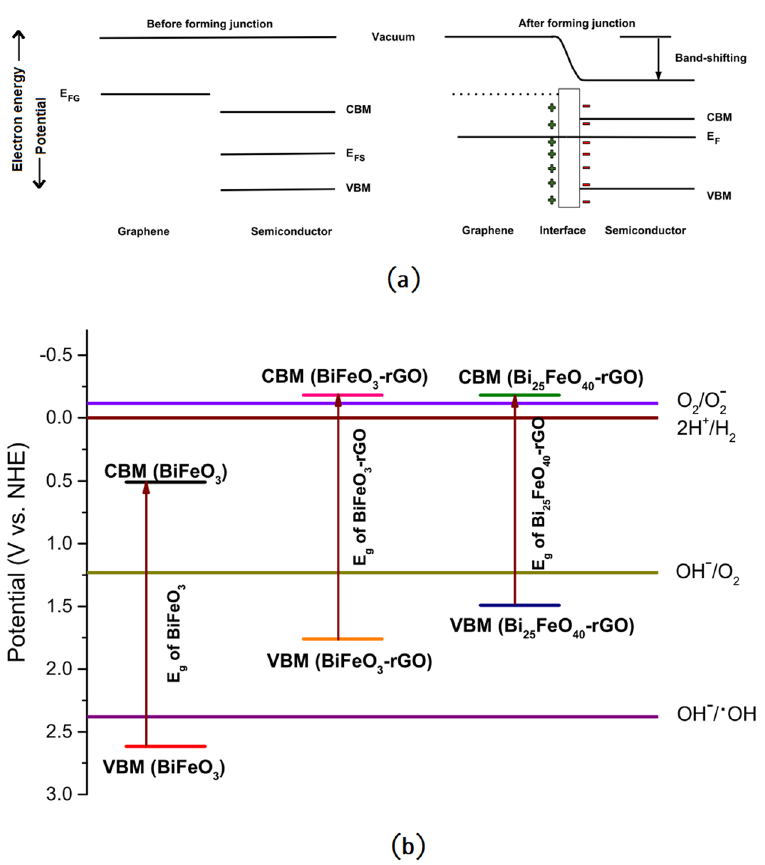
Figure 6. ( a ) Band-shifting of a nanocomposite while forming a junction with graphene ( b ) Energy band diagram of BiFeO 3 nanoparticles, BiFeO 3 -rGO, and Bi 25 FeO 40 -rGO